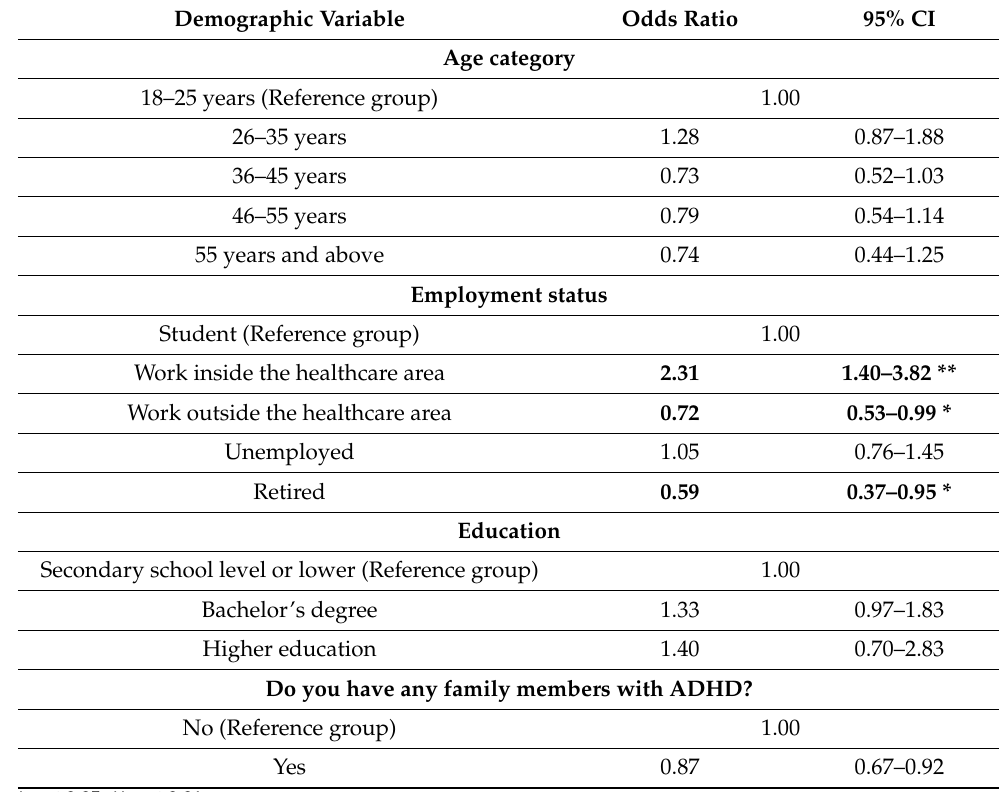
Table 3. Cont. Table 4. Binary logistic regression